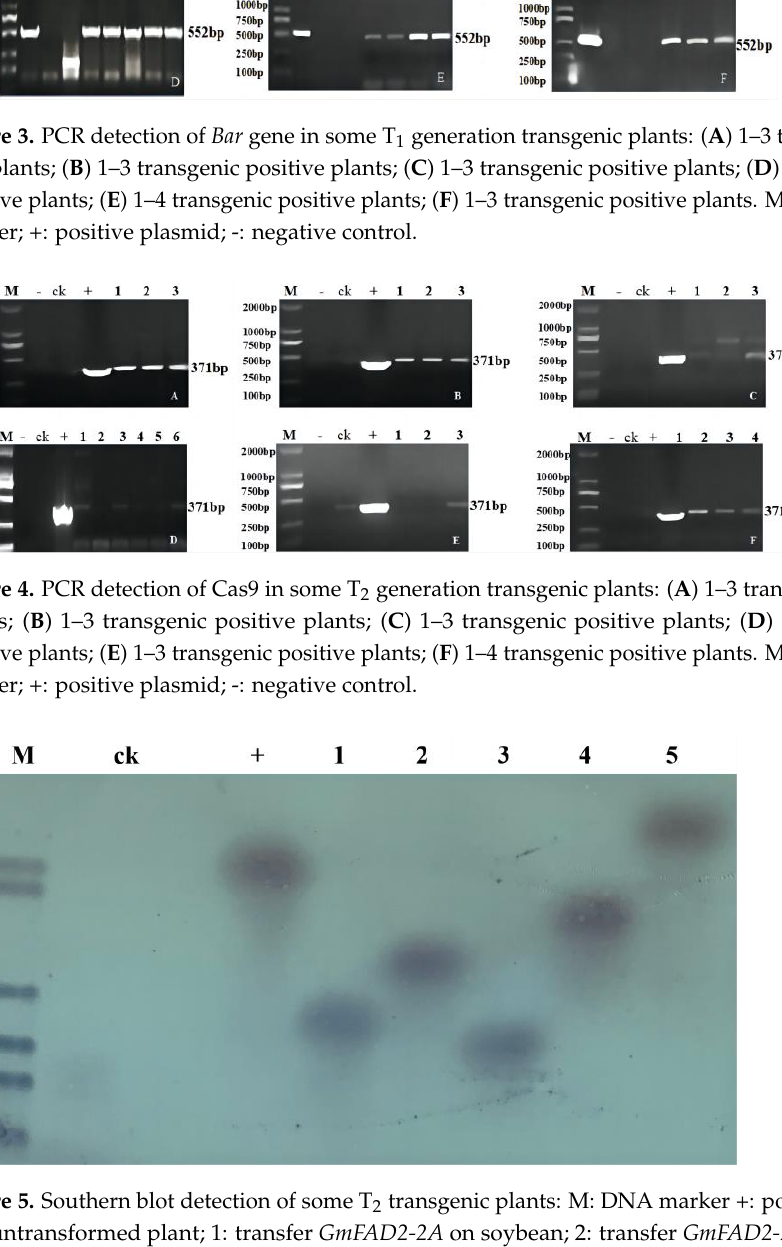
Figure 5 . Southern blot detection of some T 2 transgenic plants: M: DNA marker +: positive